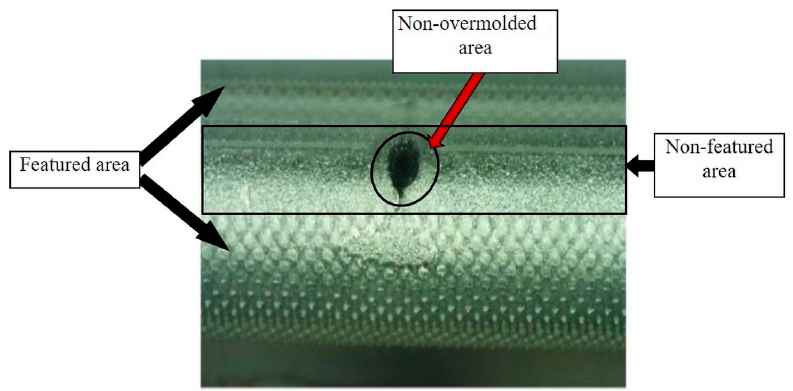
Figure 20. Mold with support for the screw.